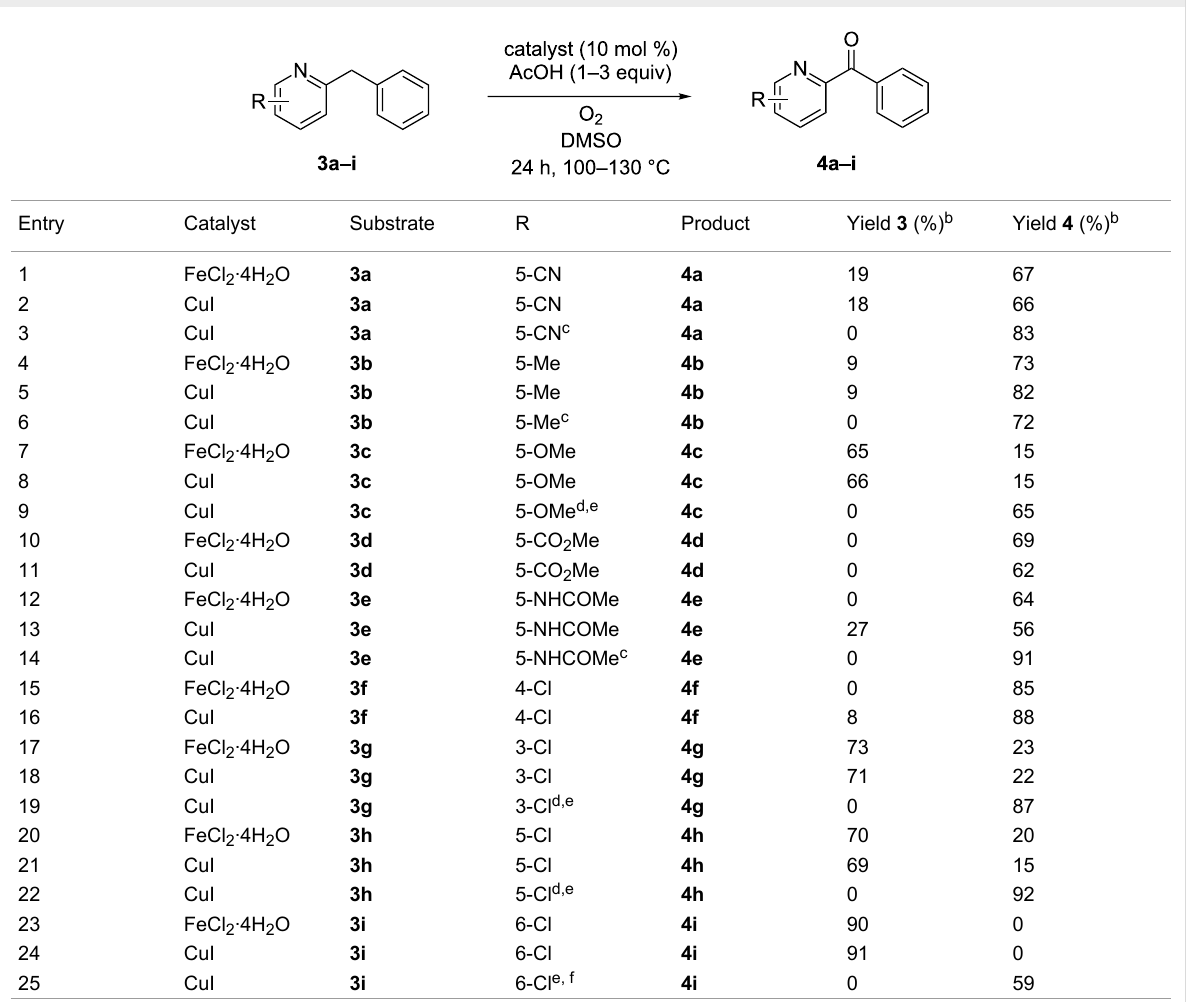
Table 2: Iron and copper-catalyzed aerobic oxidation of pyridine-substituted 2-benzylpyridines ( 3 ).